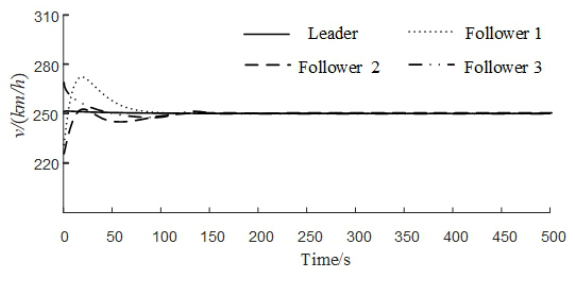
Fig. 3. Speed of trains in finite-time event-triggered